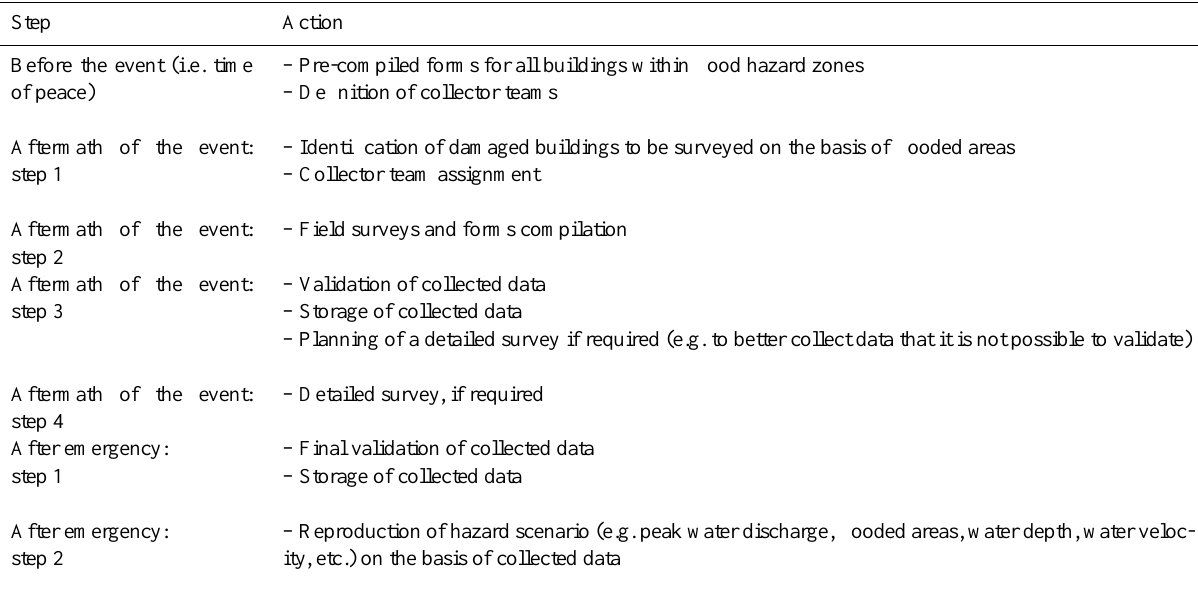
Table 4. Procedure for data collection and storage in the aftermath of flood events.